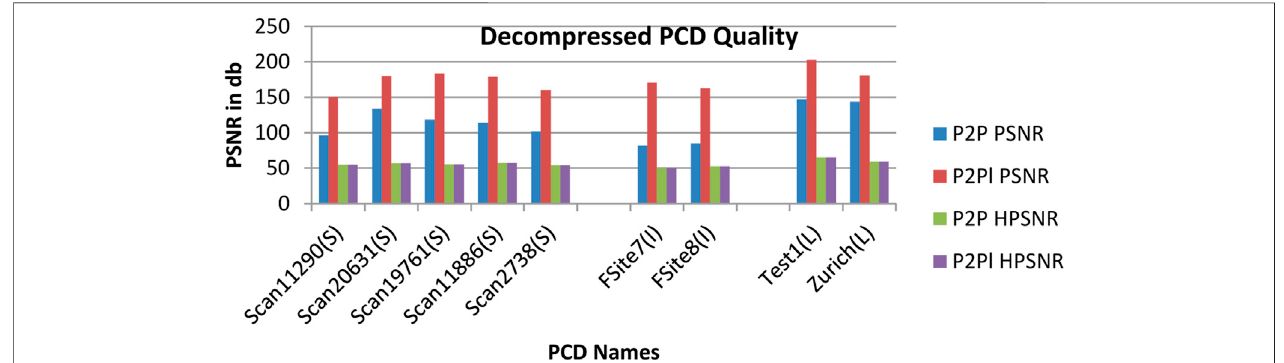
FIGURE 8 | The PSNR value of the decompressed point clouds based on P2P and P2Pl.